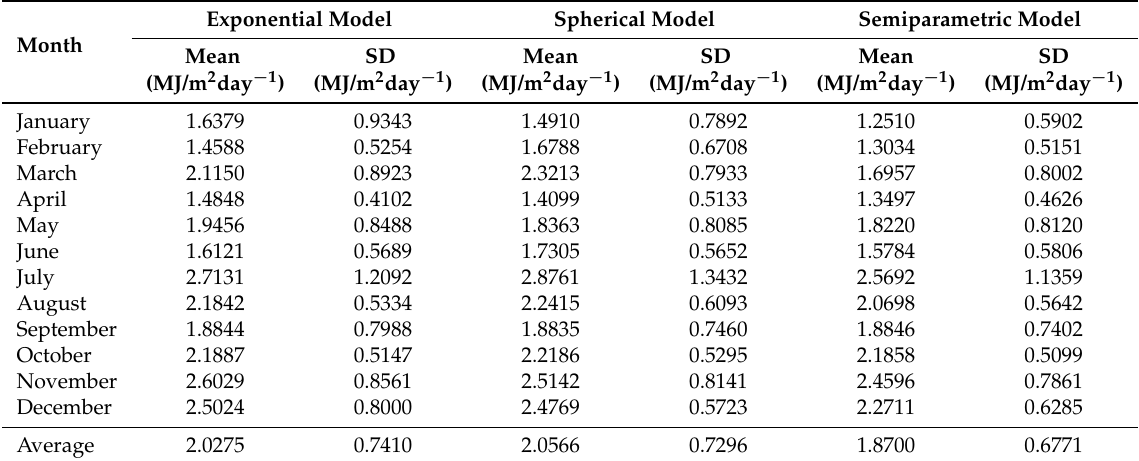
Table 2. The mean and standard deviation of root mean squared error (RMSE) of three semivariograms.